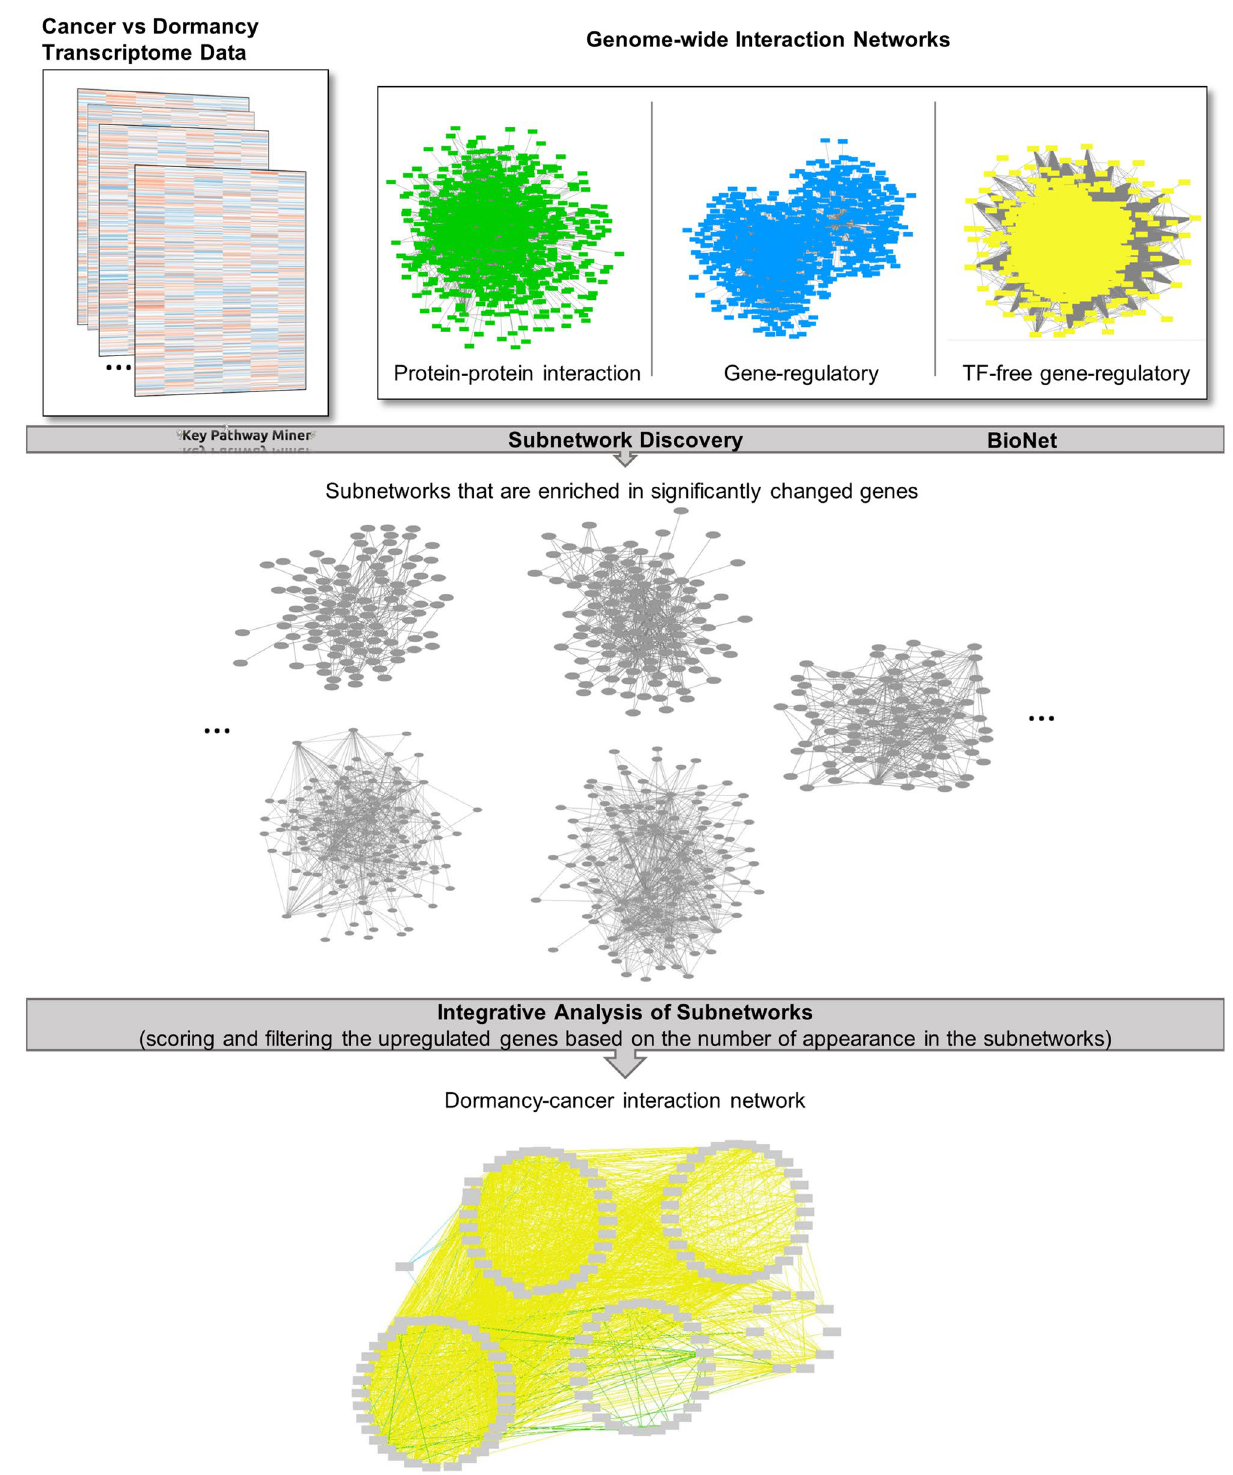
Figure 1. Summary of computational approach to construct the dormancy interaction network. Firstly, cancer– dormancy transcriptome data were downloaded from GEO database and Genome-wide interaction networks were obtained. Then, KPM and BioNet, two subnetwork discovery tools, were performed and subnetworks that are enriched in significantly changed genes were identified. Finally, the upregulated genes were scored and filtered based on the number of appearances in the subnetworks and according to this filtering, the dormancy- interaction network was constructed (see also